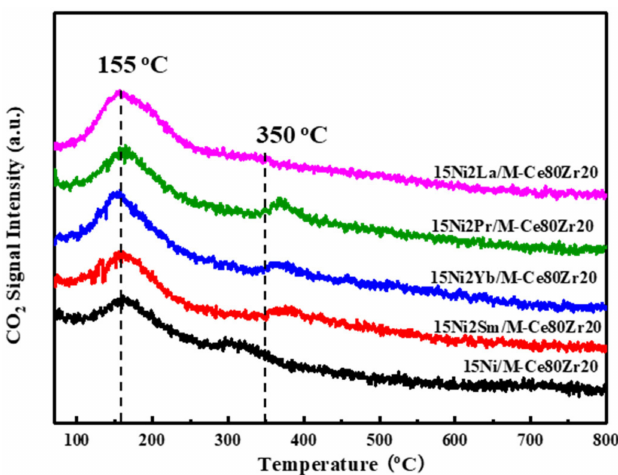
Figure 6. CO 2 -TPD profiles of the 15Ni2R/M-Ce80Zr20 (R = La, Sm, Pr, Yb)